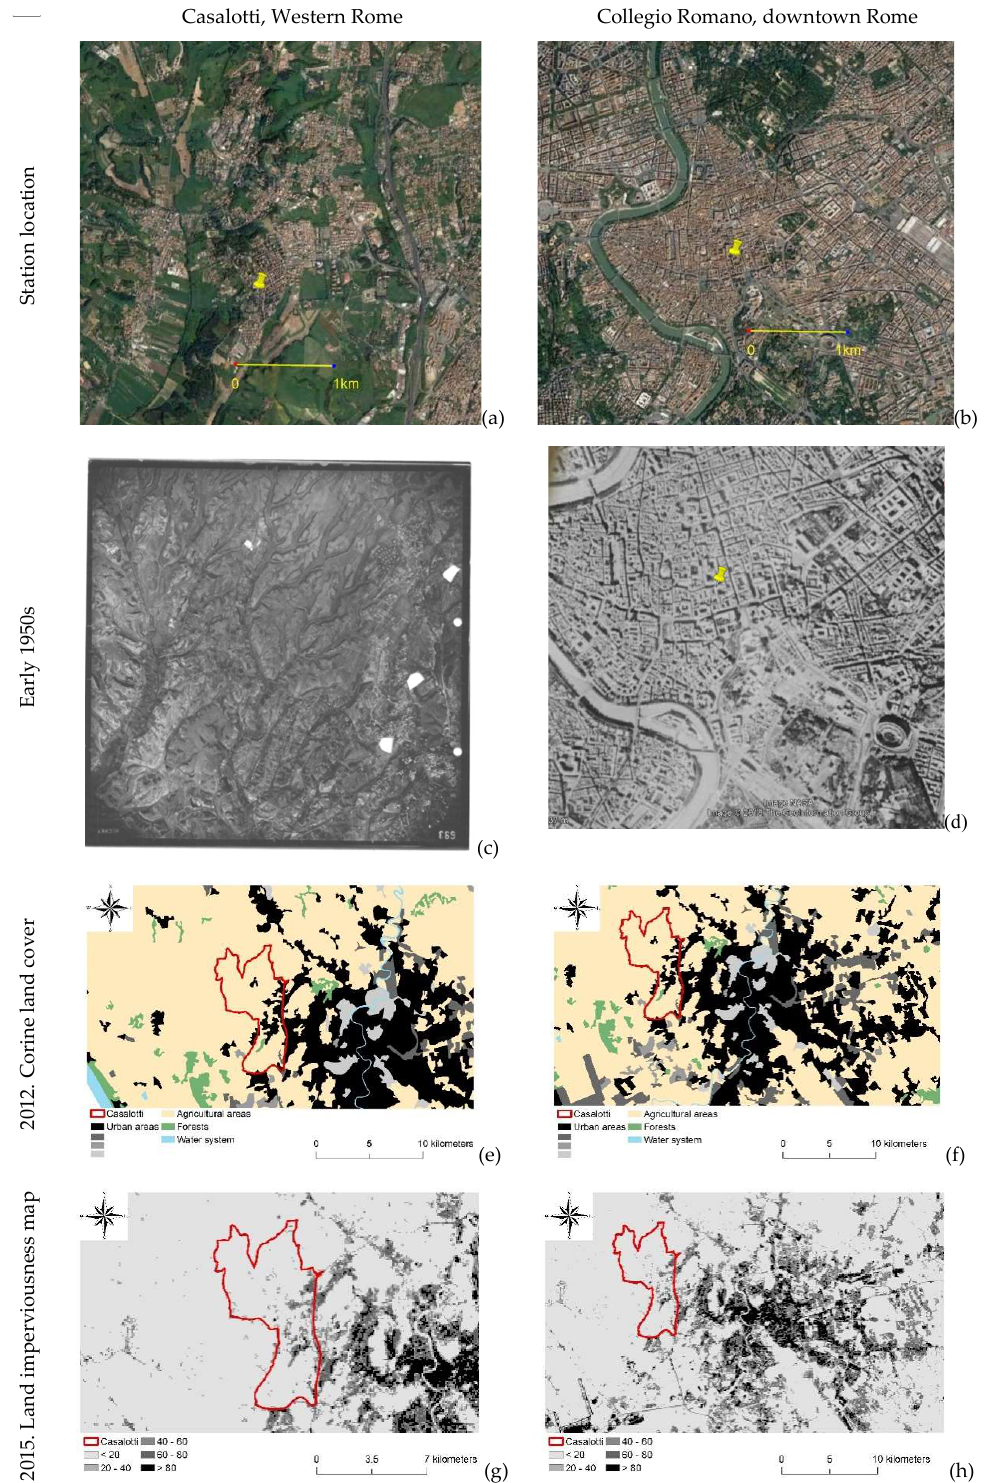
Figure 1. Maps illustrating location and basic characteristics of the two sites: Casalotti (peri-urban) and Collegio Romano (strictly urban): aerial photographs derived from Google Earth imagery of Casalotti ( a ) and Collegio Romano ( b ); maps of early 1950s of Casalotti ( c ) and Collegio Romano ( d ); maps of recent urbanization derived from Corine Land Cover maps of Casalotti ( e ) and Collegio Romano ( f ); and land imperviousness maps of Casalotti ( g ) and Collegio Romano ( h ) carried out by European Environment Agency in the framework of Land Copernicus